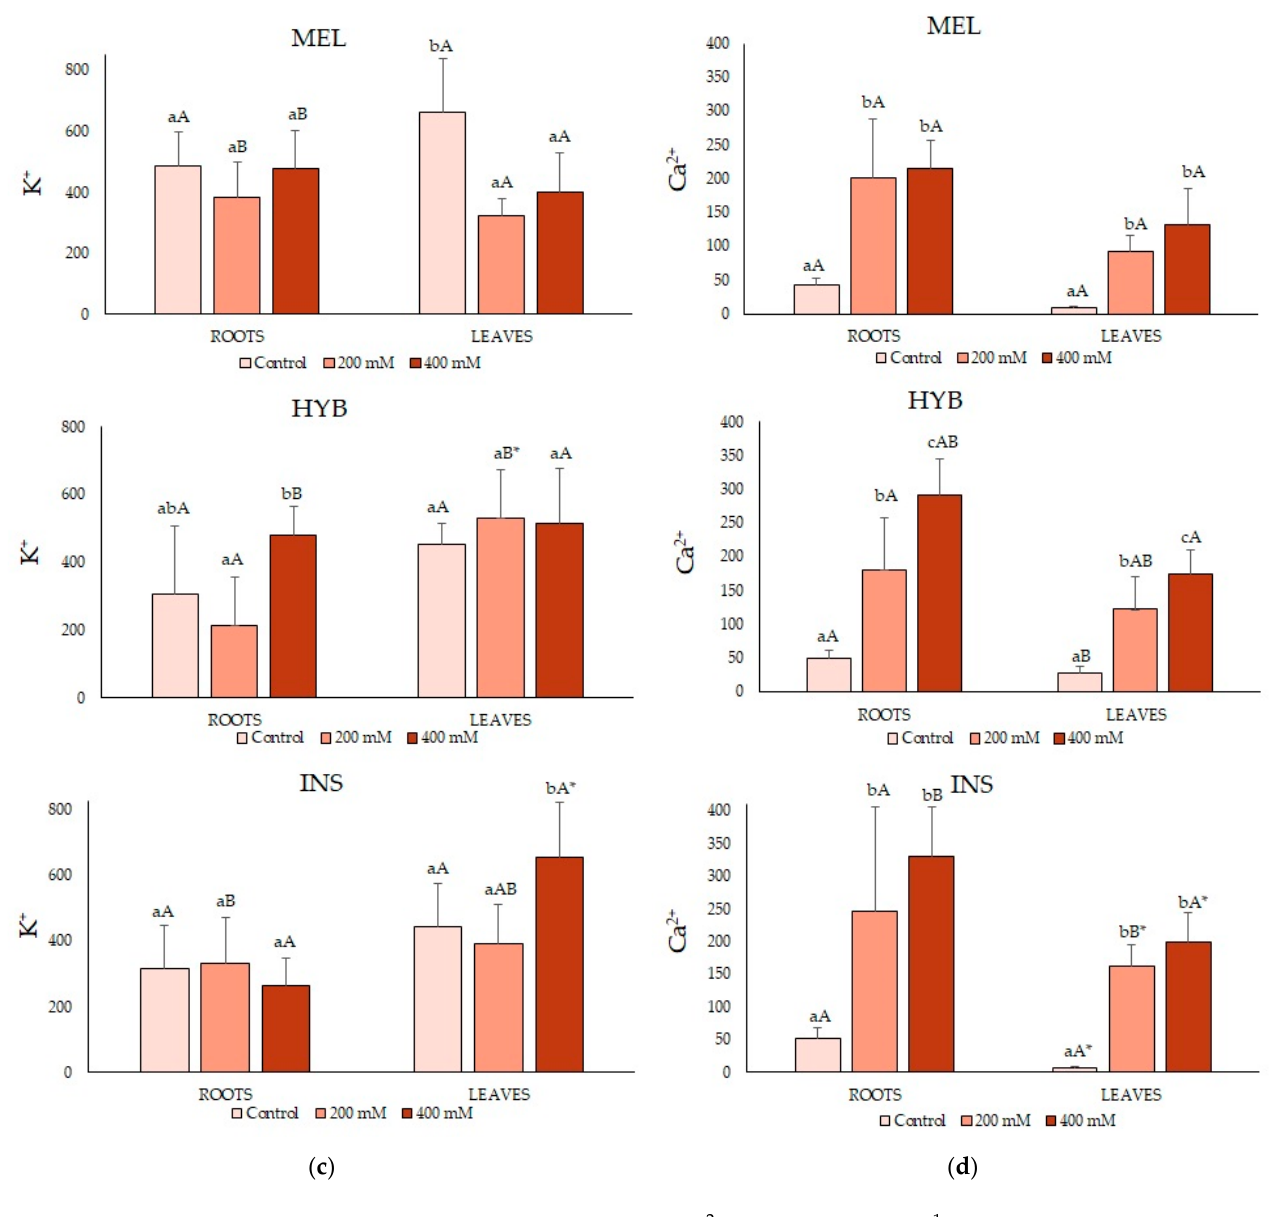
Figure 5. Na + ( a ), Cl − ( b ), K + ( c ) and Ca 2+ ( d ) content ( μ mol g − 1 dry weight) in roots (left) and leaves (right) (mean ± SD; n = 5) in Solanum melongena (MEL), Solanum insanum (INS) and their hybrid (HYB) in the conditions tested (control, 200 mM and 400 mM of NaCl). Different lowercase letters within the same genotype indicate statistically significant differences between treatments, different uppercase letters within the same treatment indicate statistically significant differences between genotypes, and an asterisk indicates statistically significant differences between roots and leaves for the same treatment and genotype ( p < 0.05), according to the Student–Newman–Keuls multiple range test.